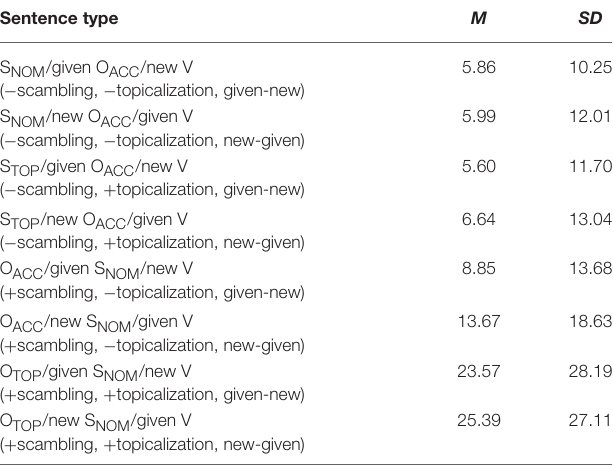
TABLE 3 | Error rates (%) for target sentences.